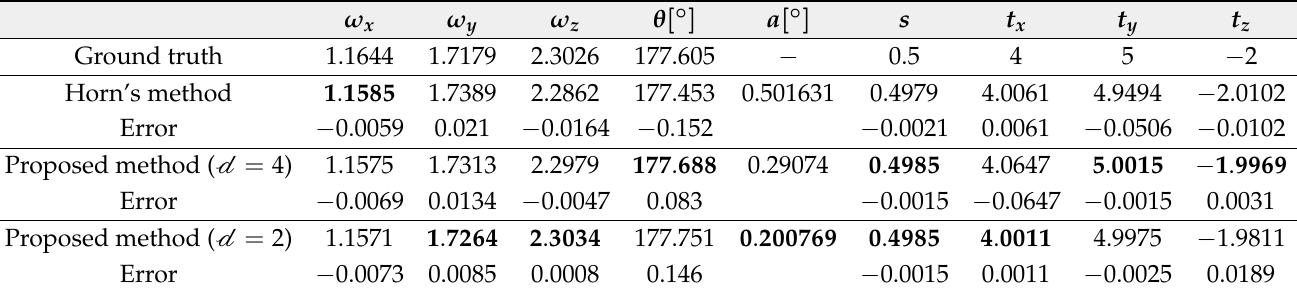
Table 1. Comparison of the relative pose estimation methods—first set of points.